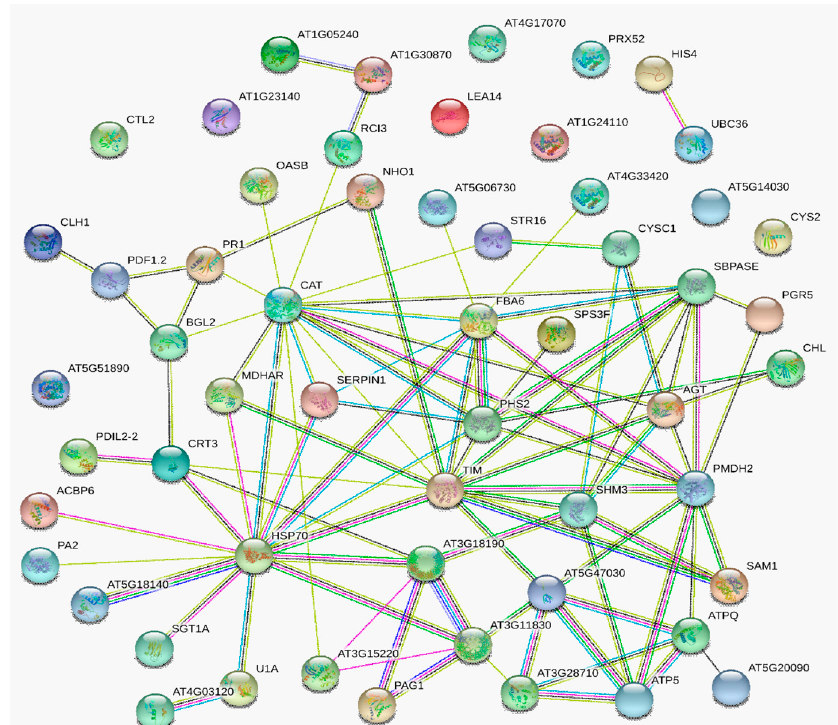
Figure 3. Interaction networks of response to stress related DAPs identified by isobaric tags for relative and absolute quantification (iTRAQ). Protein–protein interaction network constituted by DAPs identified in N9134 responding to Pst stress and known protein-species related to defense and response to biotic stimulus in the Database, Experiment, or Text Mining databases. The purples lines represent experimental evidence. The green lines represent gene neighborhood, while the blue lines represent gene co-occurrence database evidence. The yellow lines represent textmining evidence; and the black lines represent the co-expression evidence. U1A, Spliceosomal protein U1A; AT4G03120, C2H2 and C2HC containing protein (Component of the U1 snRNP C); TIM, Triosephosphate isomerase; AT3G11830, TCP-1/cpn60 chaperonin family protein; SHM3, Serine hydroxymethyltransferase Pathogenesis-related gene 1; MDHAR, Monodehydroascorbate reductase; OASB, Cysteine synthase;